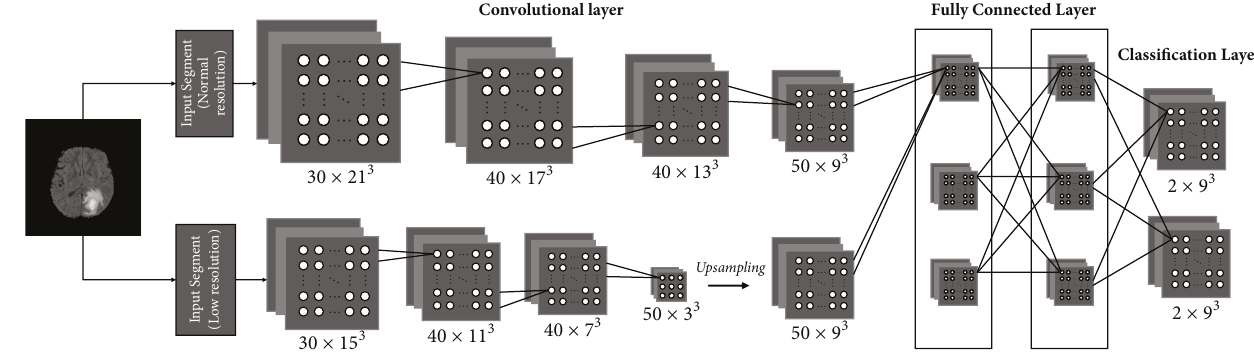
Figure 1: The basic architecture of